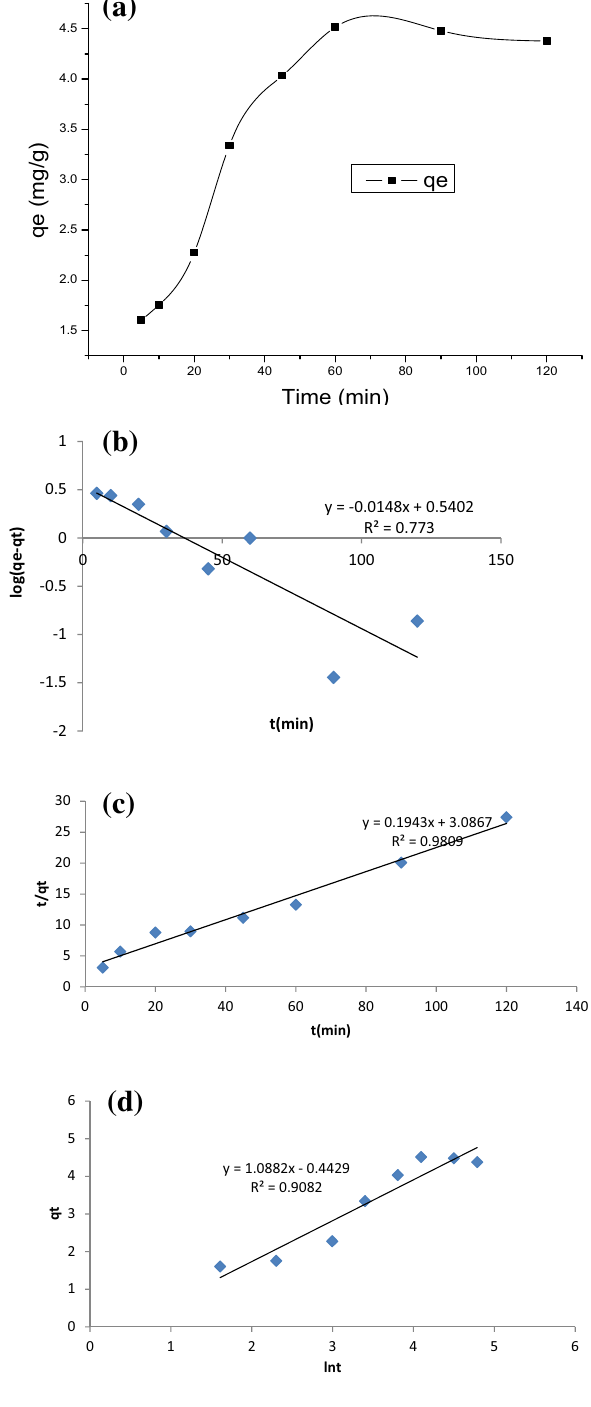
Fig. 4 a Effect of time on the sorption of BPA onto nFe Pseudo-first-order kinetic plot. c Pseudo-second-order kinetic plot. d Elovich kinetic model